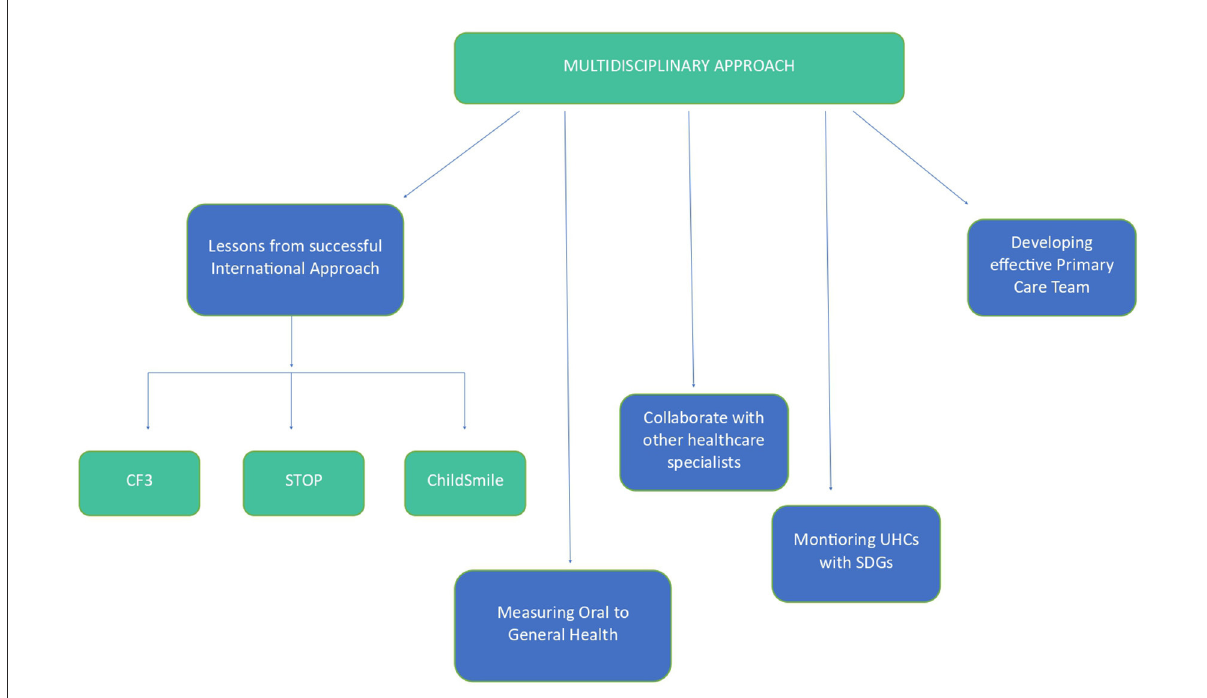
FIGURE2 Possible Oral Health related linkage to 17 SDGs.